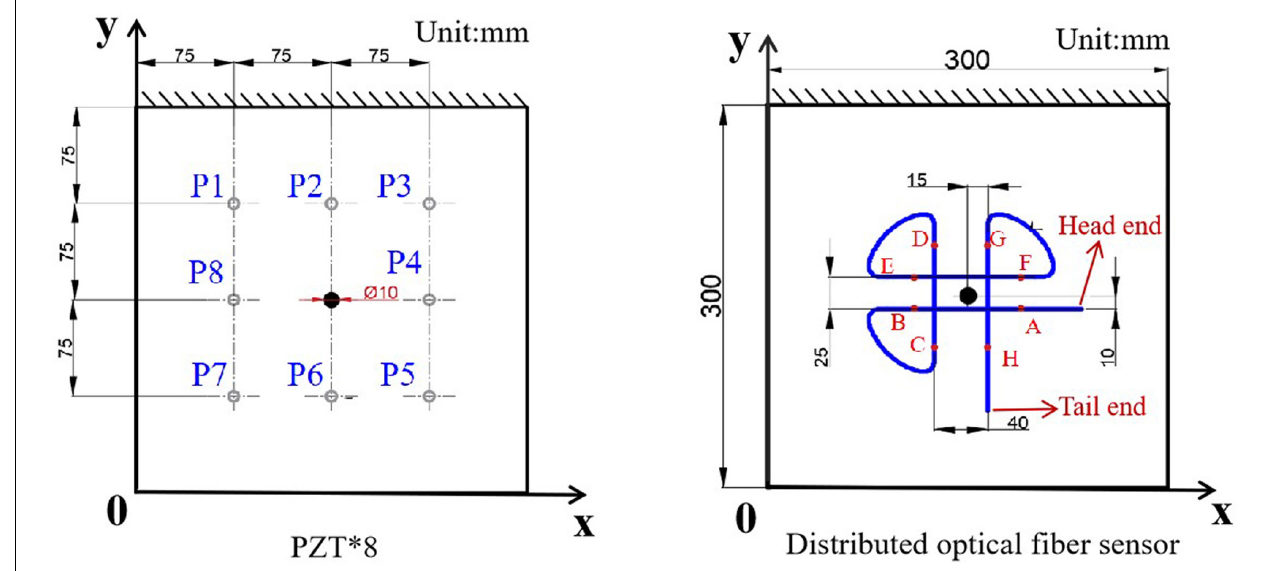
FIGURE 4 | The sensor layout of the PZTs and distributed optical fiber sensor on the same aluminum plate.